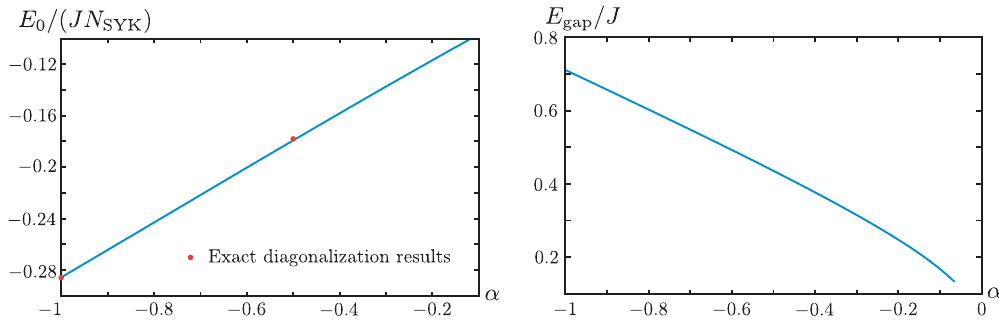
edge.FIG. 16. Right: The value of E 0 = ð JN as a function of α . Both graphs are approximately linear in α for α not too small. Results SYK Þ from exact diagonalizations [Eq. (3.33)] are shown with dots. Left: The large- N energy gap in the spectrum computed from the SYK exponential decay of the Green